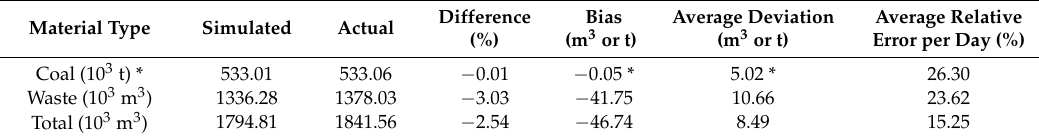
Table 5. Summary statistics of simulated and actual production data of the case Profen, Exp. 1.